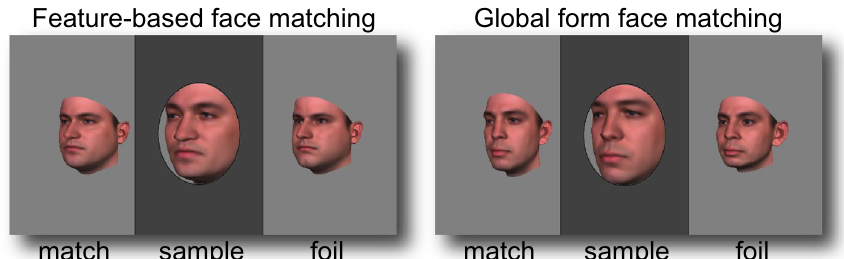
Figure 1. A zoom-in on face stimuli in two face matching trials. A sample face appeared with two choice faces—one foil and one match. The task was to pick the choice face that most resembled the sample face. In feature-based face matching (example on left), the match shared features with the sample. In global form face matching (example on right), the match shared global form with the sample. The foil shared neither features nor global form with the sample. On each trial, all faces looked left (as shown), straight ahead, or to the right, and the match could be on the left (as shown) or right of screen center. Face stimuli are from Van Belle et al. 78 .